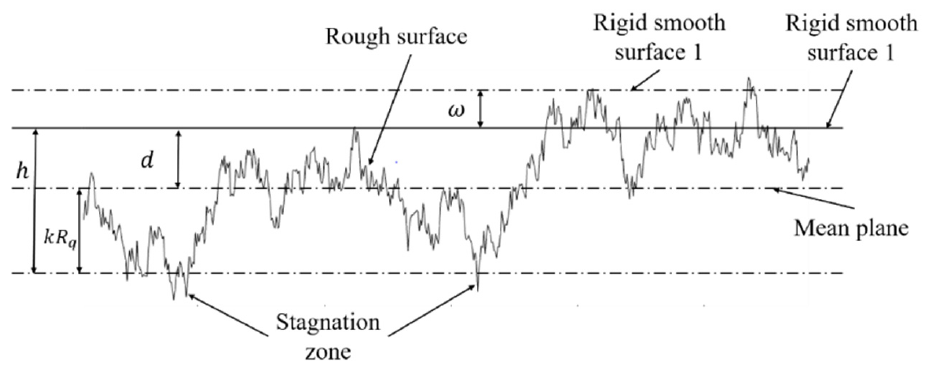
Figure 7. The contact between a rigid flat surface and a rough surface. The profile height distribution of the rough surface z ( x ) characterized by the WM function obeys the independent Gaussian distribution with an expectation of z ( x ) ∼ N ( 0, R q 2 ) [30], where R q is the root mean square deviation of the rough surface profile. It can be seen from this expression that z ( x ) is mainly concentrated in the range where the average plane is ± kR q , where k is a constant value between 1 and 3 and can be selected according